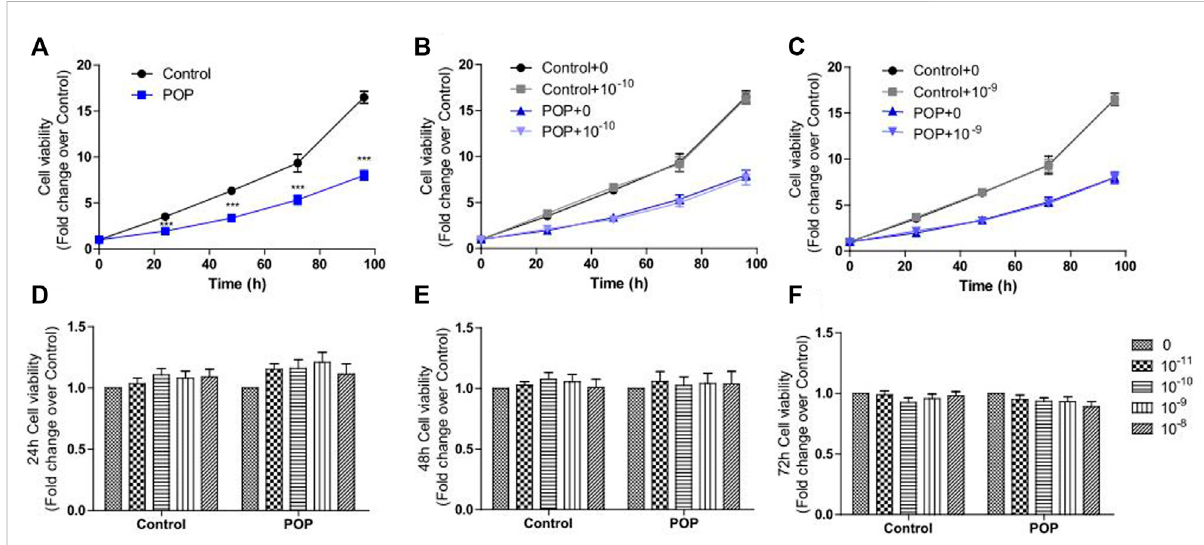
FIGURE 2 CCK8 assay was performed to determine the effects of 17 β -estradiol on cell proliferation in hUSLFs. The fi broblast cell growth rate of POP was obviously lower than that of Control (A) . Physiological 17 β -estradiol concentration (10 − 10 M (B) and 10 − 9 M (C) did not obviously in fl uence the cell proliferation for both groups in the entire culture process. Estrogen treatment increased the proliferation of both control and POP fi broblast cells at 24 h, but the increase was not statistically signi fi cant (D) and did not continue in 48 h (E) and 72 h (F) . Values are expressed as the mean ± standard deviation of three independent experiments. *** p < 0.001 POP vs